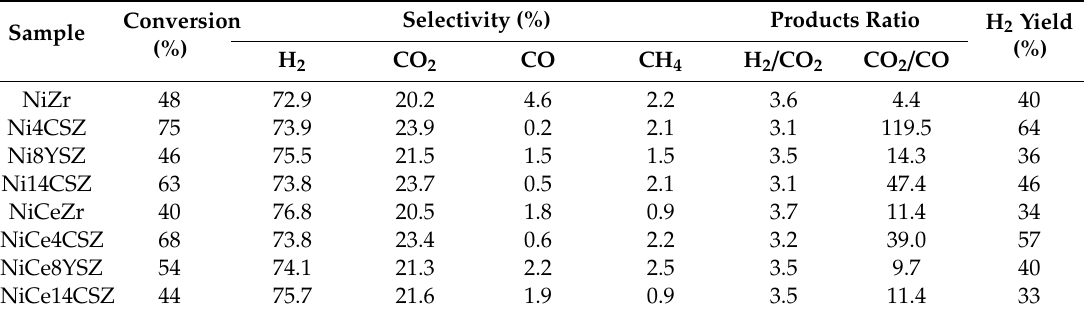
Table 6. Results from catalytic experiments.